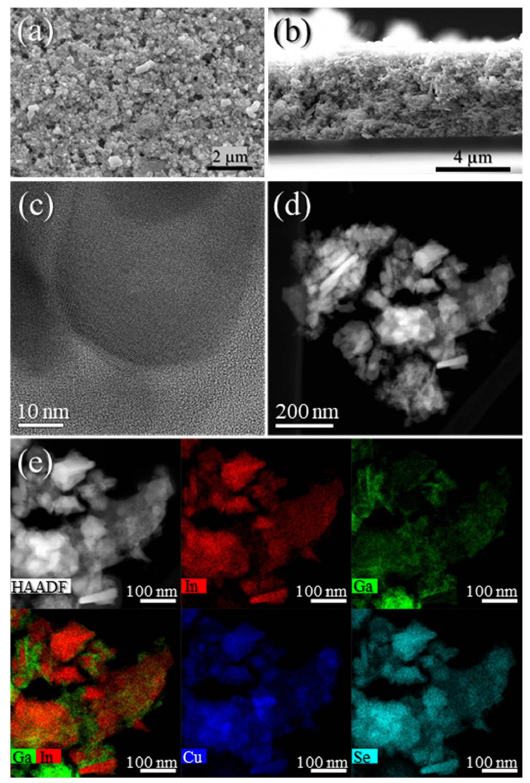
Figure 5. SEM surface ( a ) and cross-sectional ( b ) images and HAADF–STEM images ( c , d ) with STEM–EDX maps ( e ) from screen-printed film of Sample II after annealing. The resultant screen-printed film after annealing is a phase-pure CIGS with tetrago- nal chalcopyrite structure (space group (cid:1835)4(cid:3364)2(cid:1856) ) with no signs of undesirable secondary phases (Figure S9a). The major peaks found at 26.8°, 44.6°, and 52.9° correspond to (112), (220/204), and (312/116) reflections of chalcopyrite CIGS phase [14,41], respectively. The Raman data (Figure S9b) revealed a sharp peak at around 174 cm −1 , corresponding to the